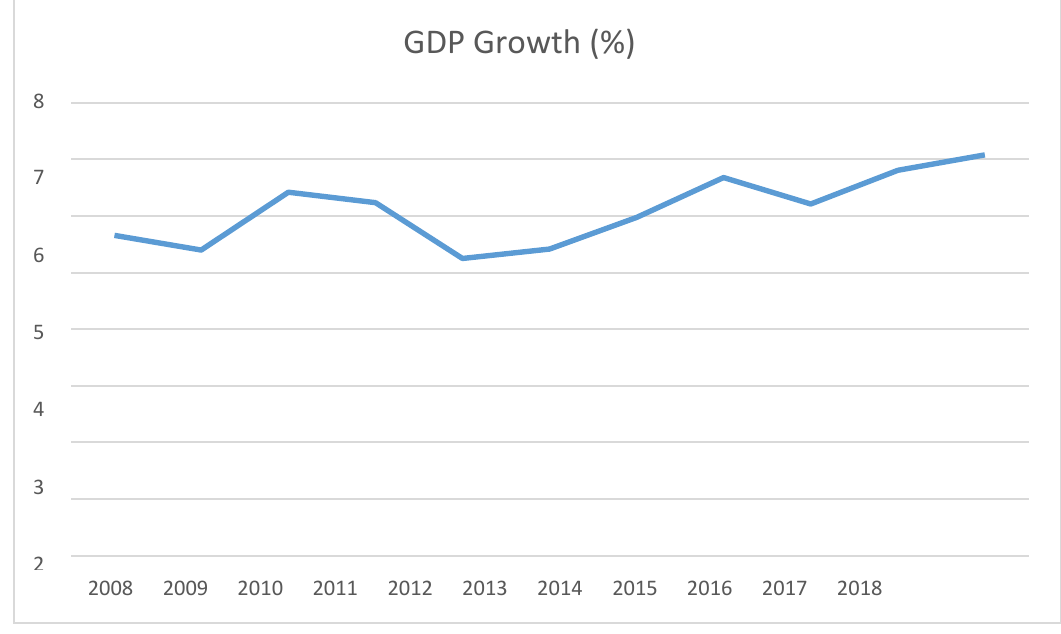
Figure 1. The GDP Growth Rate in Viet Nam during 2008-2018 (General Statistics Office of Viet Nam, 2018)